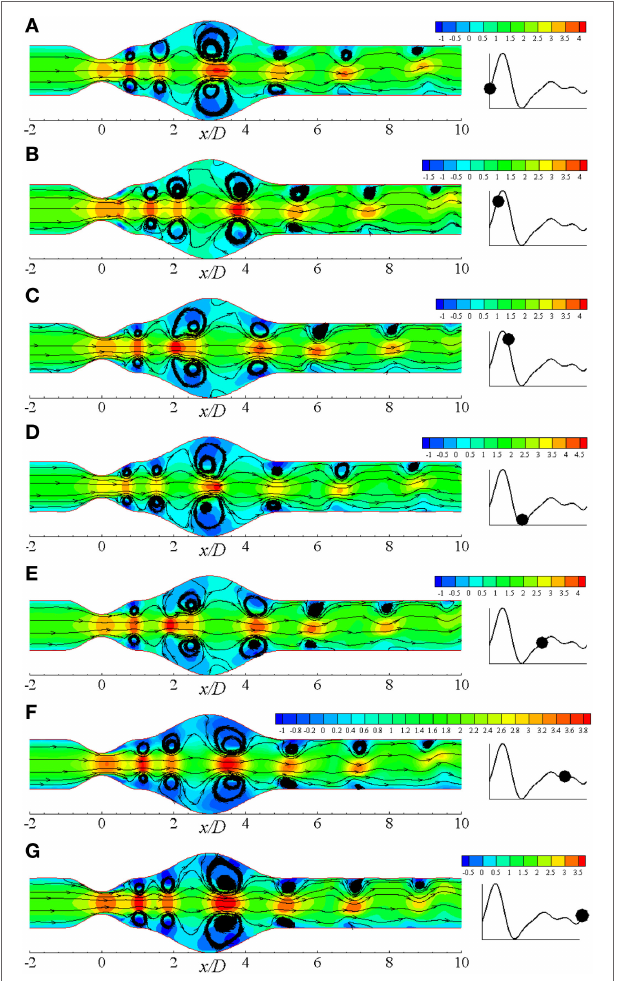
FIGURE 8 | Streamlines at different physiological phases (A) t / T = 9.0, (B) t / T = 9.1, (C) t / T = 9.2, (D) t / T = 9.3, (E) t / T = 9.5, (F) t / T = 9.7, (G) t / T = 9.10 when aneurysm = 100% dilated and stenosis = 60% constricted for Re = 300 where the amplitude of wall oscillation, A = 3 (cid:2) 10 (cid:0) 4 .